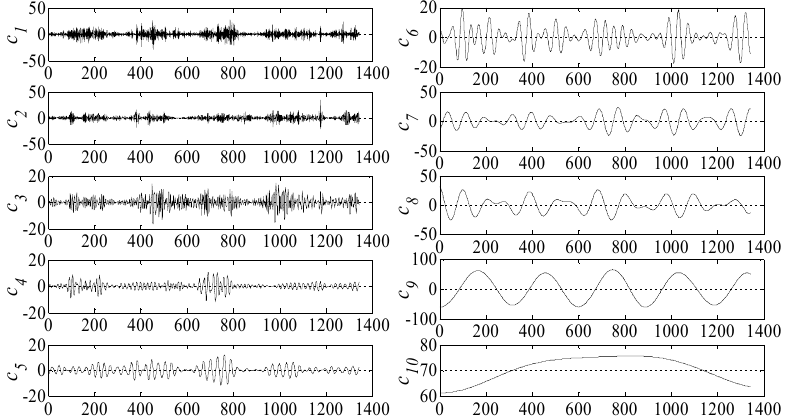
Figure 4. The pictures of TVF-EMD decomposition results (A).